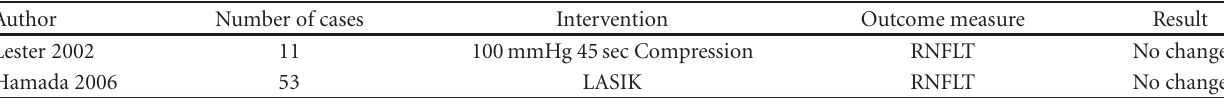
Table 2: Investigational